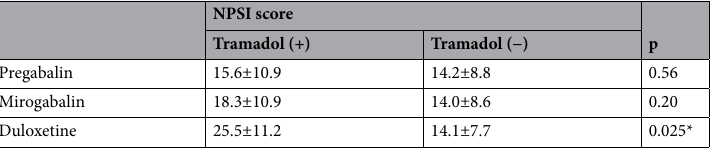
Table 2. Differences in NPSI scores with and without the concomitant use of tramadol. NPSI Neuropathic Pain Symptom Inventory.